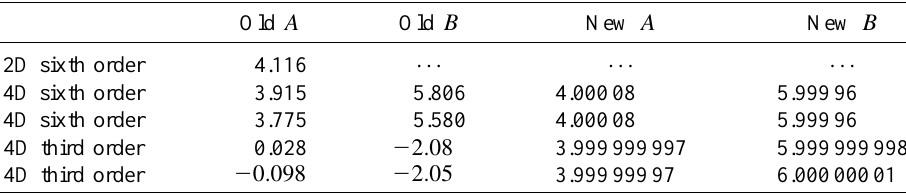
TABLE I. Fixed points used and results of their residues: first solution.